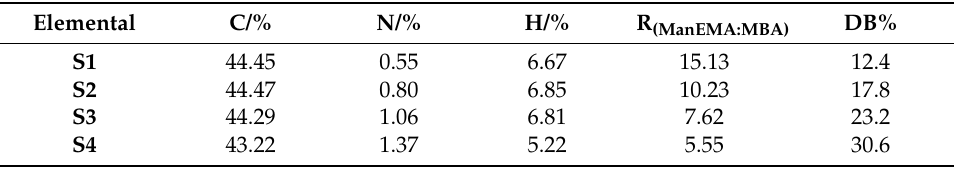
Table 2. Elemental analysis of C, N, H for HPManEMA- co